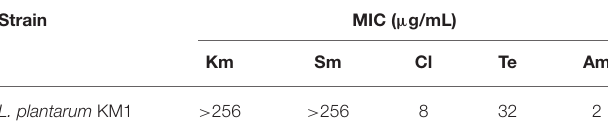
TABLE 1 | The minimum inhibitory concentration of L. plantarum KM1 to antibiotics. Strain MIC ( µ g/mL) Km Sm Cl Te Am L. plantarum KM1 > 256 > 256 8 32